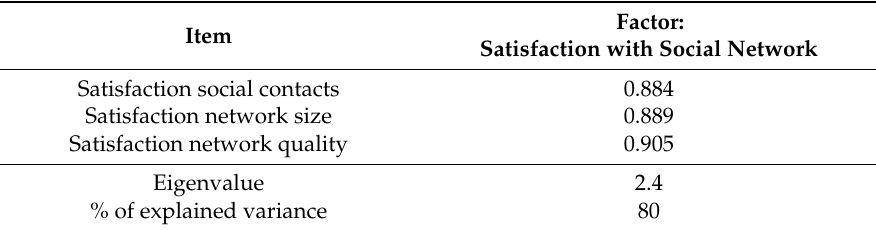
Table 2. Principal component analysis social participation.